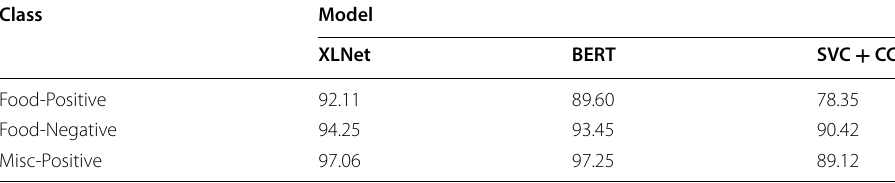
Table 9 Class based accuracy of the top-three classes in the YP dataset Class